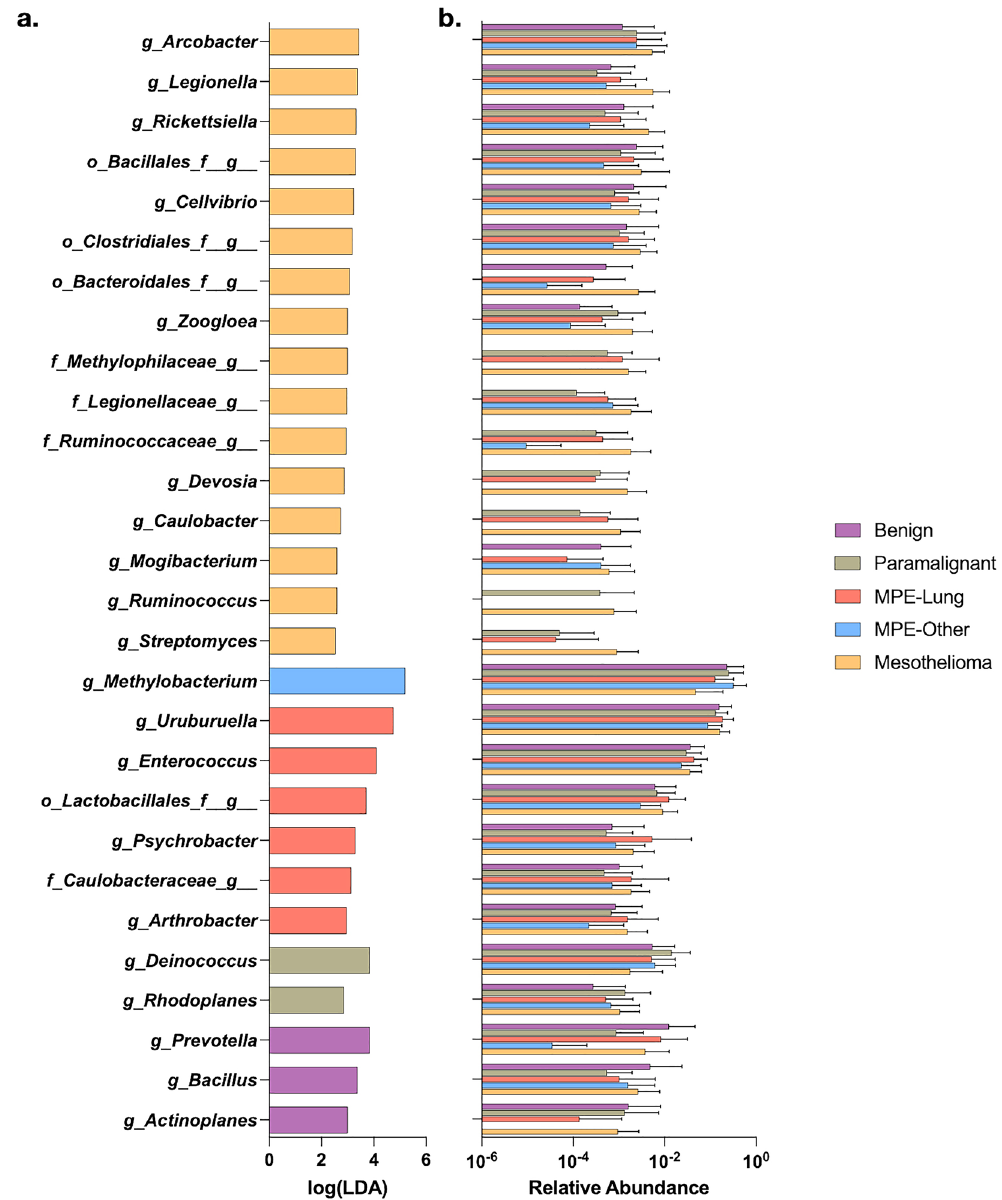
Figure 2. Taxonomic differences between groups of pleural fluid. ( a ) Identification of taxa enriched in group of pleural fluid by linear discriminant analysis effect size (LEfSe). ( b ) Mean relative abundance for each taxa identified as enriched by